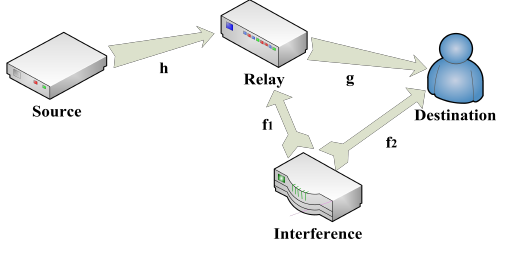
Fig. 1: System model.